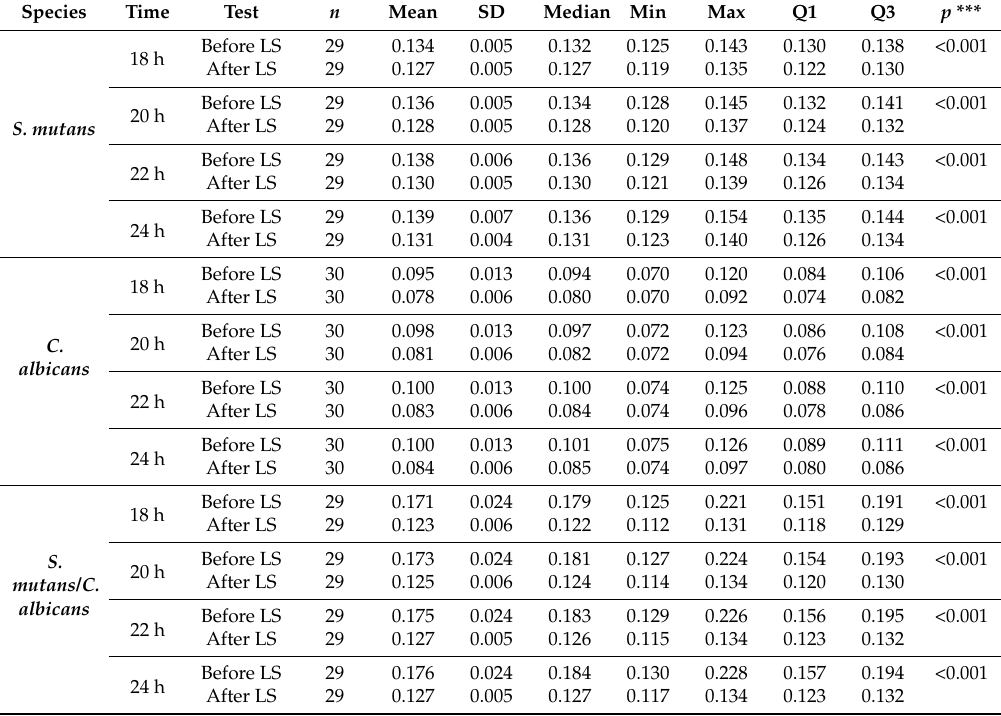
Table 3. S. mutans , C. albicans , and oral streptococci/yeast biofilm formation: total biomass (OD) evaluation before and after administration of Lactobacillus salivarius (HM6 Paradens, LS) at individual time